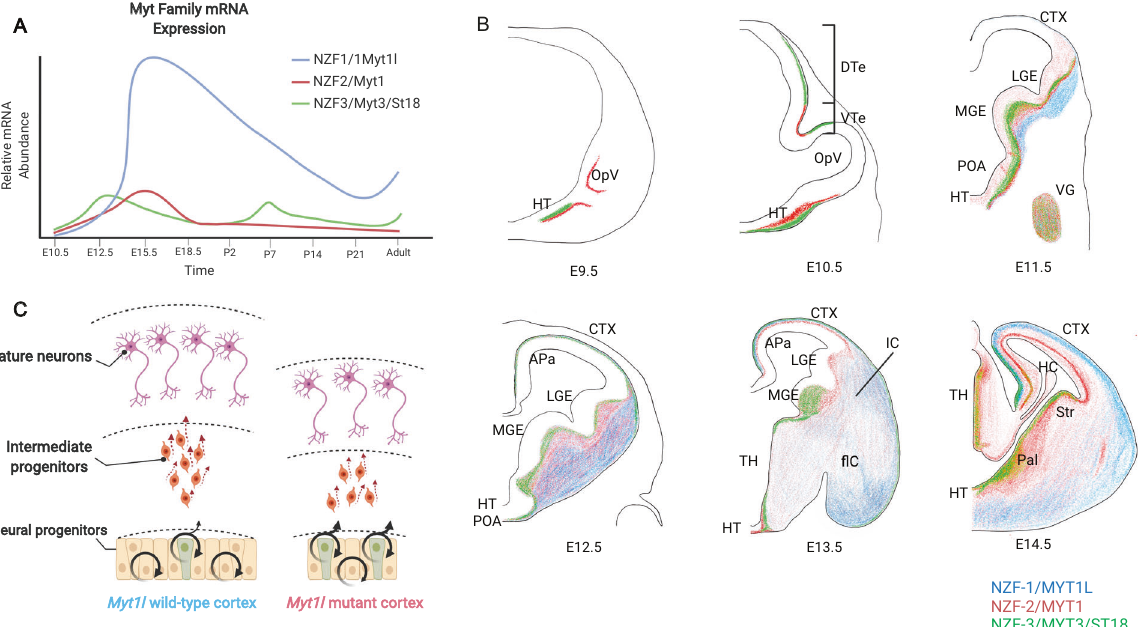
Fig. 2 Mouse embryonic brain expression patterns of MYT family transcription factors. A Quantitative RT-PCR summarized as relative mRNA expression of Myt1 (red), Myt1l (blue), and Myt3 (green) in the developing mouse from E10.5 to adult, adapted from [13]. B Color coded summary of published in situ hybridization data from Matsushita et al. [13] showing the spatial expression pattern of MYT1, MYT1L, and MYT3 in the developing cortex. C The diagram shows a hypothesized mechanism of microcephaly in Myt1l mutant mice at E14. APa, archipallium; BG, basal ganglia; CTX, cortex; DTe, dorsal telencephalon; fIC, fi bers of the internal capsule; HC, hippocampus; HT, hypothalamus; IC, internal capsule; LGE, lateral ganglionic eminence; MGE, medial ganglionic eminence; OpV, optic vesicle; Pal, pallidum; POA, preoptic area;